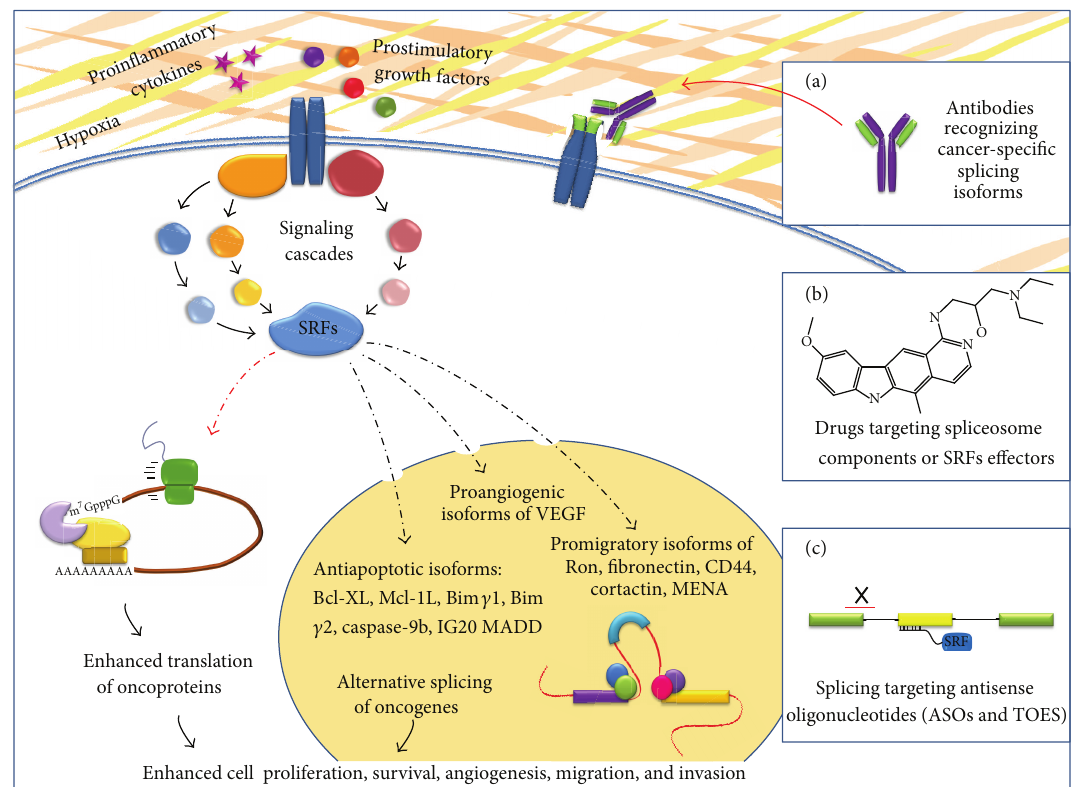
Figure 1: SRFs (splicing regulatory factors) at the cross-road between oncogenic signaling pathways and targets for anticancer treatments. During tumorigenesis, cancer cells are exposed to stressing conditions such as hypoxia and acidosis. In this altered tumor microenvironment, growth factors and cytokines, provided by either cancer or non-tumoral cells, activate signaling cascades affecting both the activity and/or the expression levels of splicing regulatory factors (SRFs). In the cytoplasm, SRSFs can enhance the translation of oncogenic variants involved in key aspects of cancer cell biology. In the nucleus, SRFs are mainly involved in the regulation of alternative splicing of pre-mRNAs relevant to cancer progression mechanisms, namely, pro-liferation, angiogenesis, survival, invasion, and metastasis. Alternative splicing variants of cancer-related genes represent powerful targets for new therapeutic approaches. (a) Alternative splicing can generate unique epitopes in cell surface proteins that can be targeted by monoclonal antibodies (mAbs), able to lead to down-regulation or neutralization of the specific isoforms. Moreover, mAbs can be also used to selectively deliver bioactive molecules to cancer cells without affecting normal tissues. (b) Small molecules, by interfering with the spliceosome assembly or with the phosphorylation status of SRFs (i.e., SR proteins), can in turn affect the balance of alternative splicing products, preventing the generation of cancer-associated variants. (c) Standard ASOs (antisense oligonucleotides) block the interaction between the splicing machinery and the cognate splicing sequences (splice sites, enhancer or silencer elements), whereas TOES (targeted oligonucleotide enhancers of splicing) oligonucleotides contain a “tail” of ESE sequences to recruit SRFs on a specific alternative exon. By inhibiting or activating specific splicing events, TOES can be used to shift the ratio between biologically functional splice variants toward the production of non-pathological